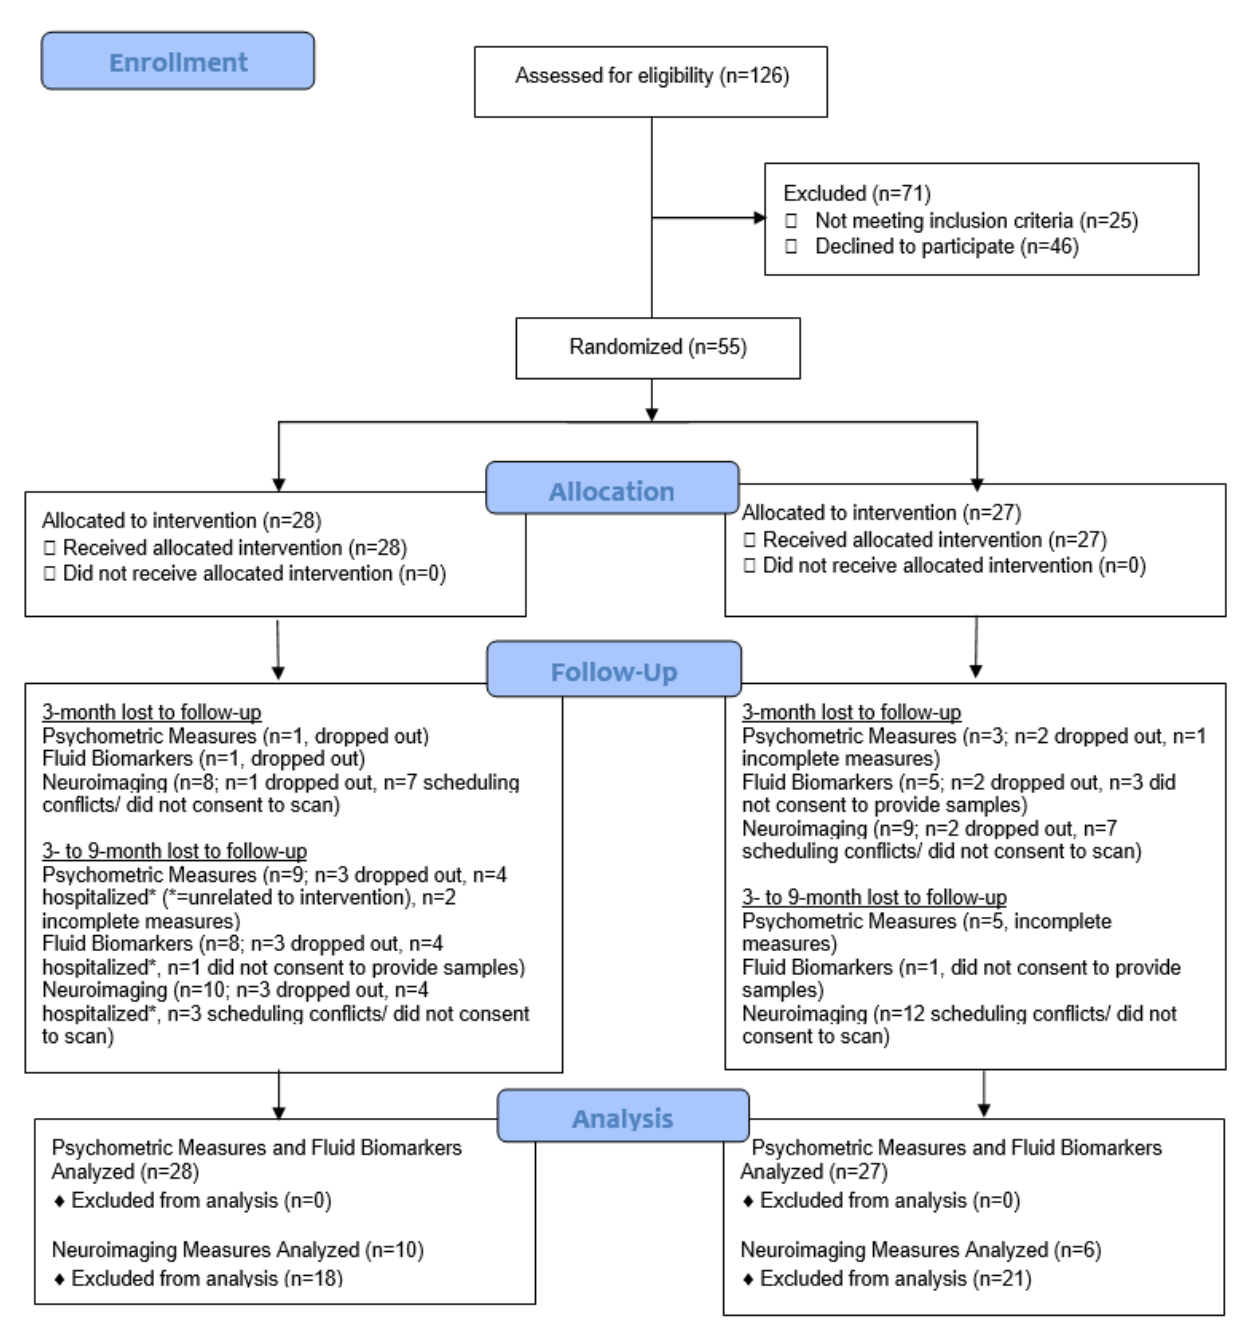
Figure 4. CONSORT 2010 Flow diagram for co-primary outcome measures.